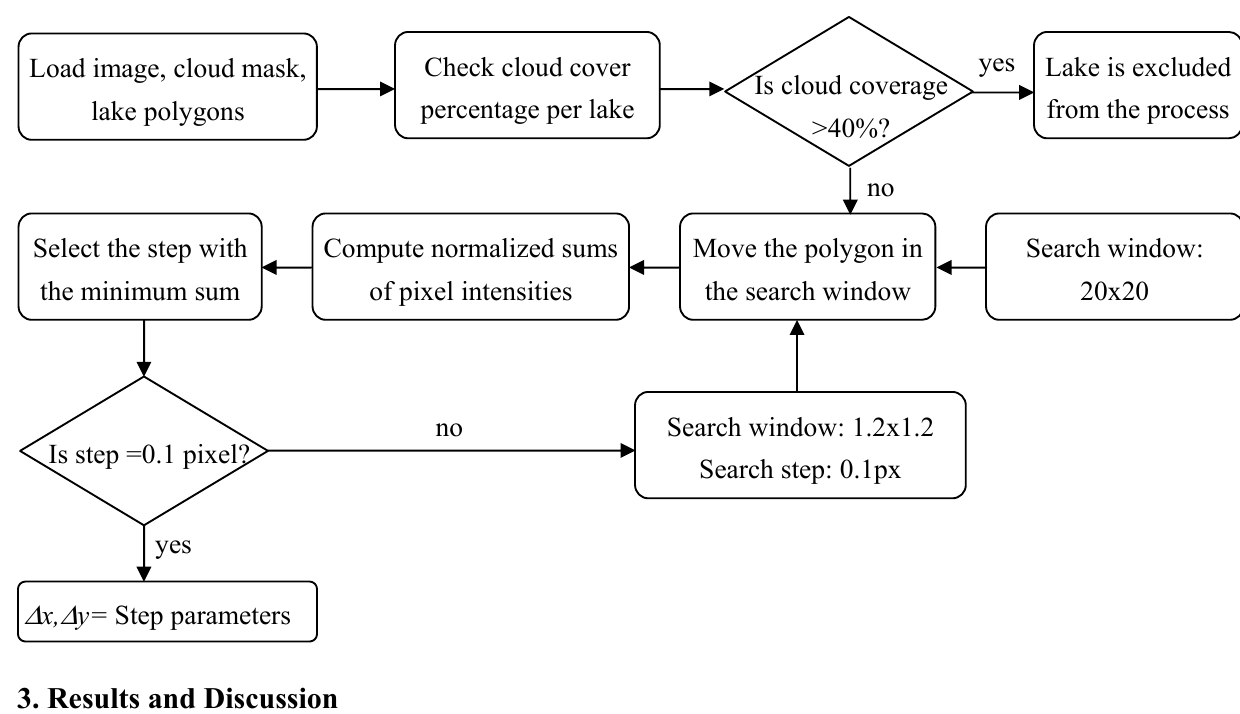
Figure 5. Algorithm for lake matching in an HRV image.